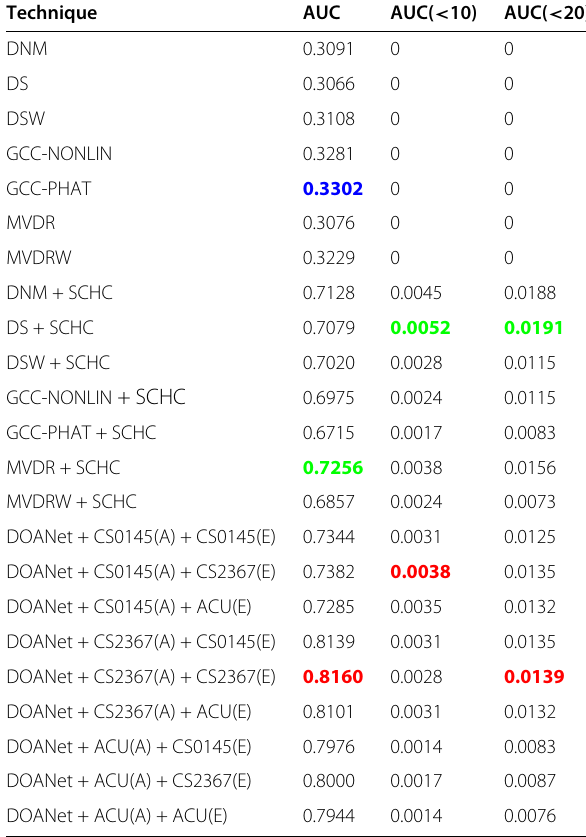
Table 9 AUC of in-flight great-circle angular distance